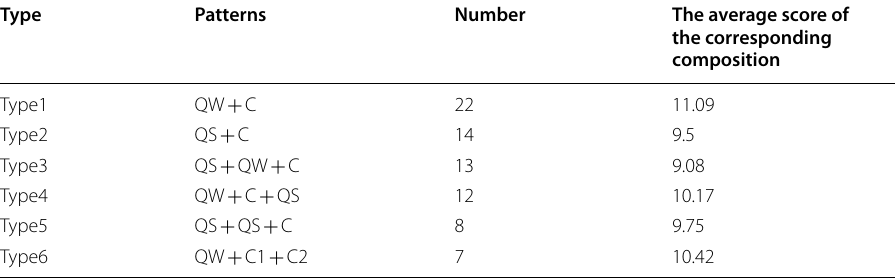
Table 9 Types of claims with high frequency Type Patterns Number The average score of